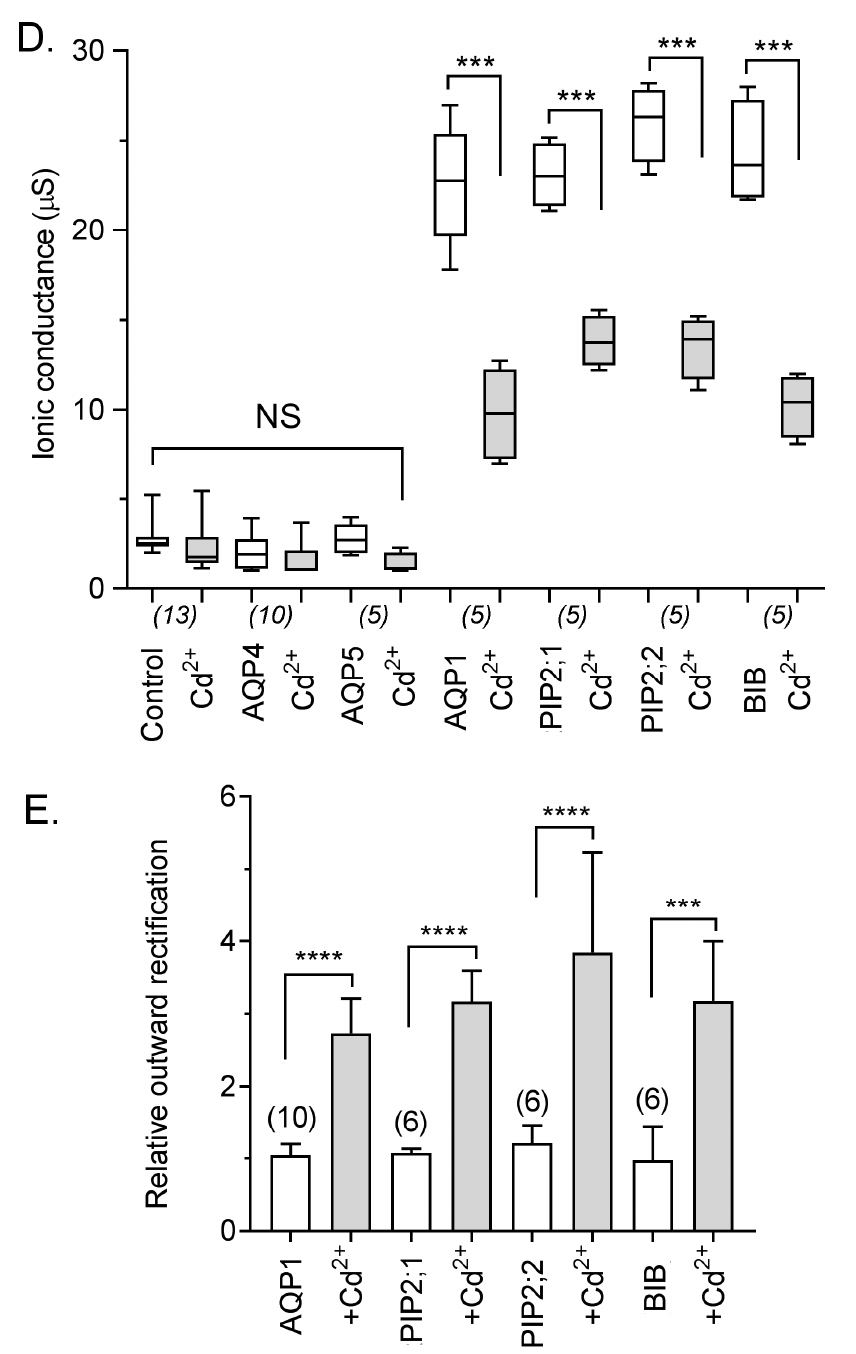
Figure 4. Effects of Cd 2+ on ion current responses in oocytes expressing different classes of AQPs. ( A ) Superimposed current traces under voltage clamp recorded at maximal activation (if present) in divalent-free saline ( left ) and after perfusion with bath saline containing 1 mM CdCl 2 ( right ). ( B ) Current-voltage relationships for data presented in ( A ). ( C ) Rates of onset of block after perfusion of bath saline containing 1 mM Cd 2+ , as measured using repeated voltage steps to +40 mV. ( D ) Box plot summary of compiled data for control, AQP4, AQP5, AQP1, PIP2;1, PIP2;2 and BIB expressing oocytes before and after Cd 2+ application. n values are below the x -axis. ( E ) Histogram showing relative outward rectification values (mean ± SEM), calculated as the ratio of outward to inward currents at +60 and − 80 mV (I +60 /I -80 ). **** ( p < 0.0001); *** ( p < 0.005); NS (not significant); using ANOVA with post-hoc Bonferroni tests; n values are shown above the histogram bars.